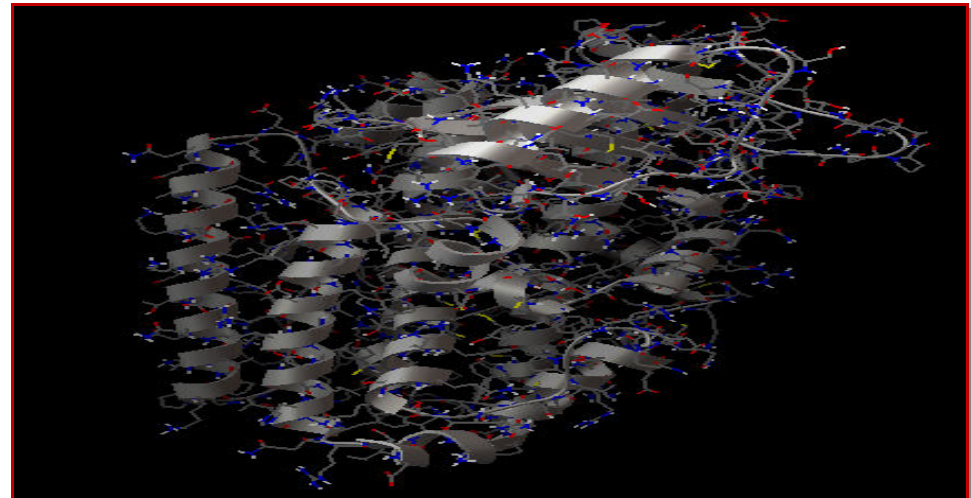
Figure 1: Lipoxygenase enzyme from RCSB